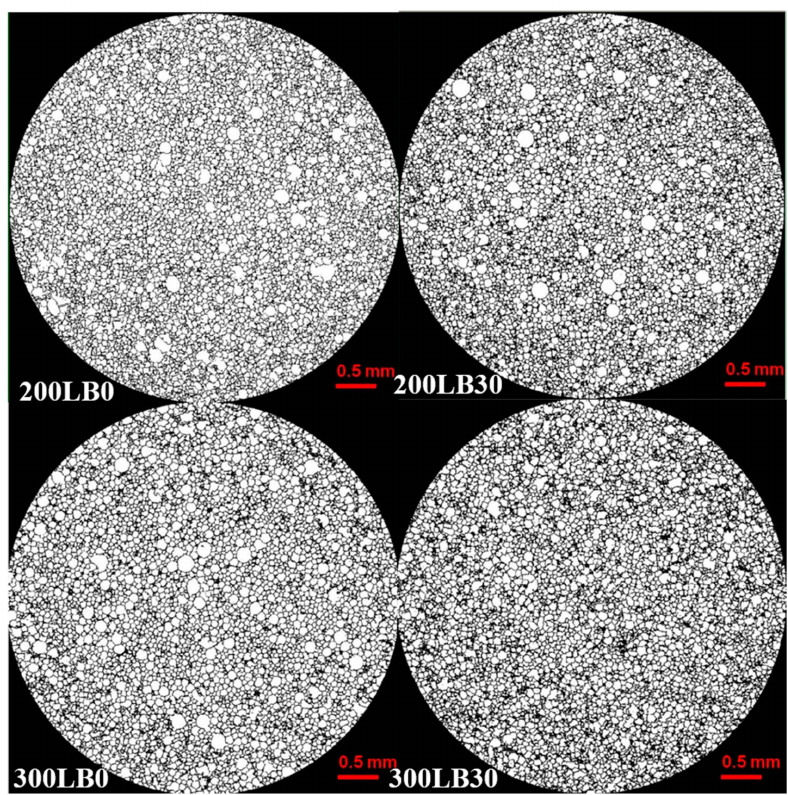
Figure 7. Midsection microCT scans after reconstruction and after watershed operation of anisotropic di ff usion of specimens.